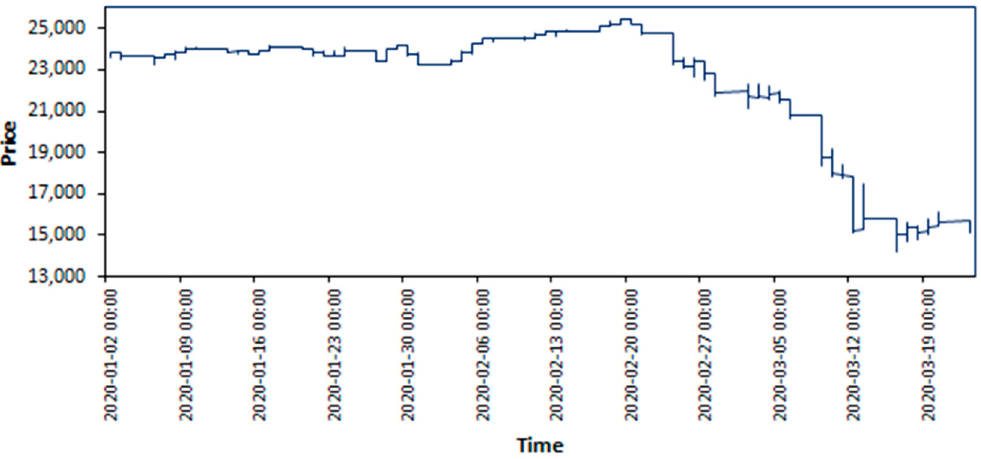
Figure 1. Five Minute Fluctuations in Italian stock market index (FTMIB) from 1 January 2020 to 23